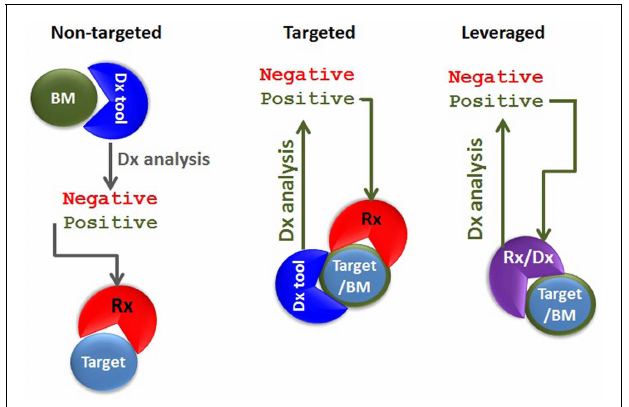
FIGURE 1 |Types of theranostic agents . In non-targeted theranostics (left panel), the biomarker (BM), the diagnostics (Dx) tool, the target, and the therapeutic agent (Rx) are separate entities. In the targeted theranostics (middle panel), the target and the biomarker are one and the same, but the Dx tool and the Rx are separate entities. In the leveraged theranostics (right panel), the diagnostic and the therapeutic agent share molecular